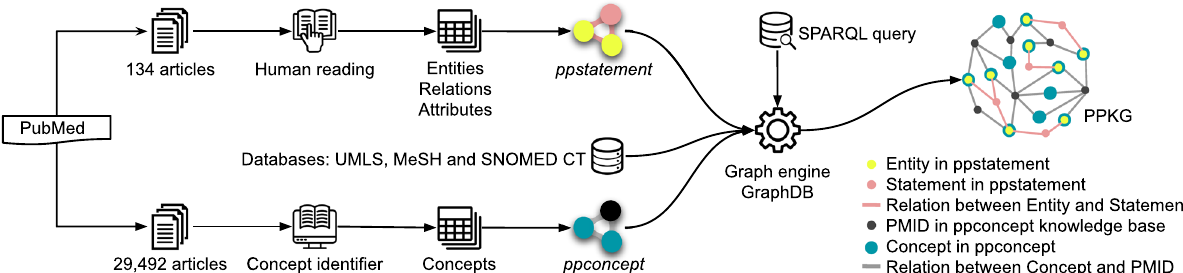
Figure 1. The workflow of the two-level construction process for PPKG. First, detailed annotations are manually extracted from 134 selected articles to construct the ppstatement knowledge base. Second, broadly covered concepts are automatically annotated from 29,492 retrieved articles to form the ppconcept knowledge base. The two knowledge bases are integrated with the other databases as PPKG in GraphDB, which supports accessing and reasoning over data with SPARQL query